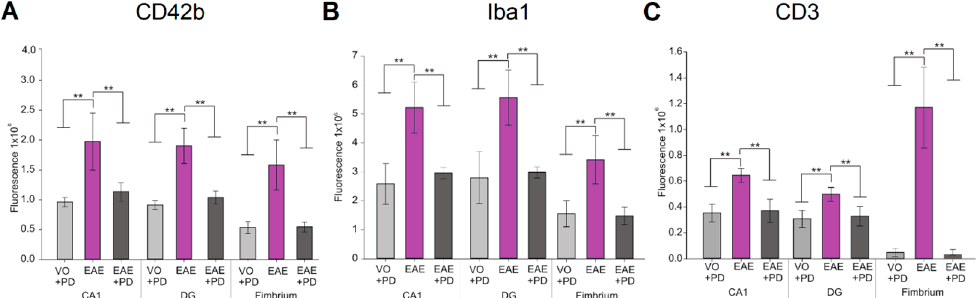
Figure 5. Quantification of platelet entry into the hippocampus and hallmarks of neuroinflammation. Immunofluorescence signals from each region shown in Figure 4 and from vehicle-only/platelet depleted (VO + PD), EAE-induced/isotype control-treated (EAE), EAE-induced/platelet depleted (EAE + PD) groups were captured and estimated by ImageJ using an arbitrary scale, with n = 4 mice/group × 6 sections/mouse. ( A ) CD42b (platelets), ( B ) Iba1 (microglial reactivity), and ( C ) CD3 (T lymphocytes) showed significantly higher expression in the EAE group relative to VO + PD and EAE + PD groups (** = p < 0.01). There was no significant difference between VO + PD and EAE + PD groups for all markers.